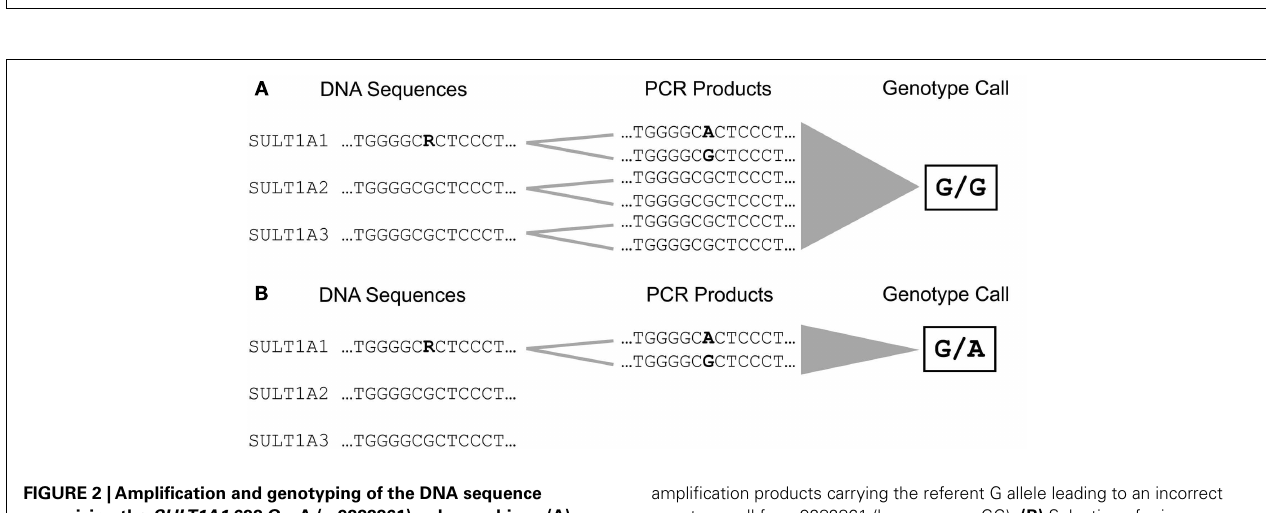
FIGURE 1 | Sequence homologies among the three members of the SULT1A gene subfamily located at chromosome 16 (NT_010393.16). A DNA fragment of 484 base pairs shows: the genetic variants SULT1A1 638 G > A (rs9282861, bold) and 667 A > G (rs1801030, bold/italic) as well as 100